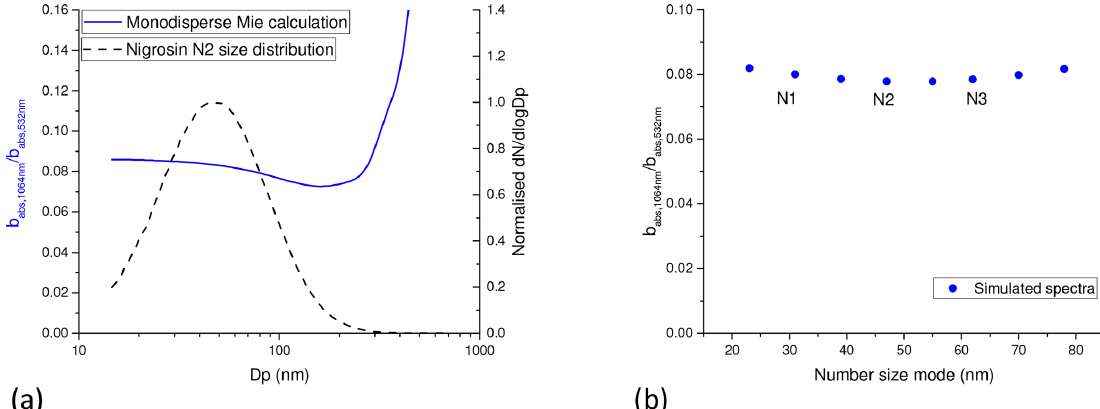
Figure 8. The absorption ratio b abs , 1064nm /b abs , 532nm calculated for monodisperse nigrosin (blue) and an example of the size distribution for the aerosolized nigrosin solution N2 (a) . Modelled absorption ratio calculated for various log-normal size distributions (b) . The number size mode of aerosolized nigrosin samples N1, N2 and N3 is marked. Table 2. Mie calculated and measured absorption and scattering coefficients at 532nm for aerosolized nigrosin N2 for several independent experiments (designated A, B and C) during the AeroTox 2020 and Ljubljana 2021 campaigns. Size distribution below 400nm was used for Mie calculation. Experiment mean values and standard errors are presented. b abs , Mie b abs , meas . b